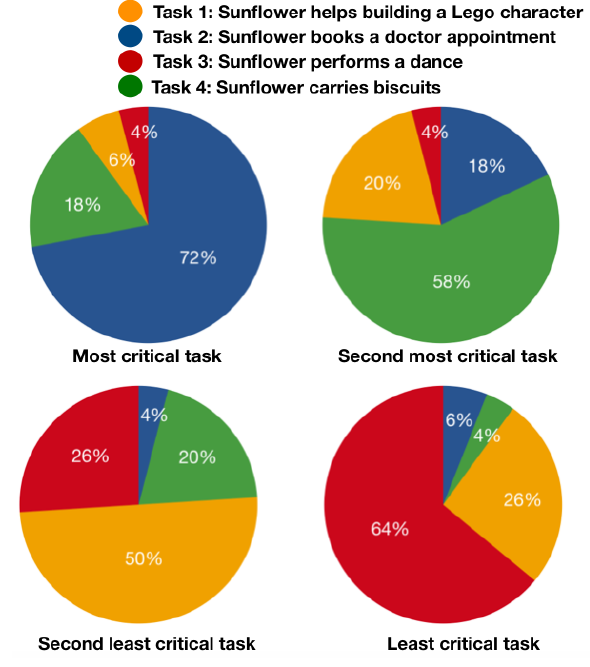
Figure 19: Task criticality